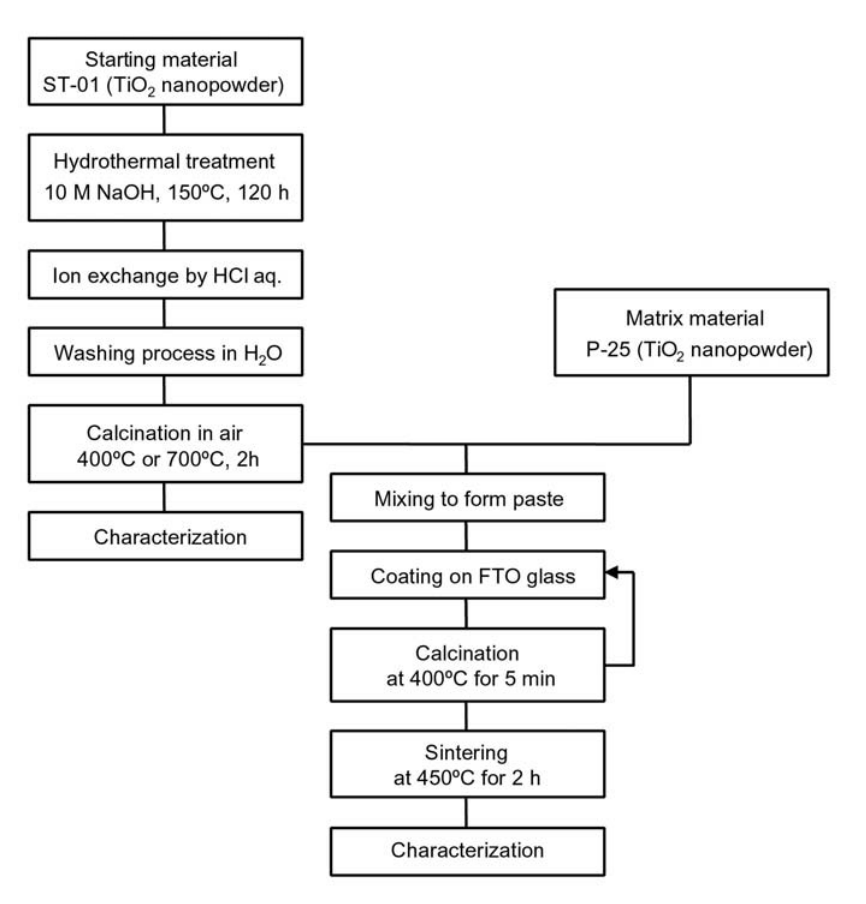
Fig. 2 Schematic illustration of the experimental